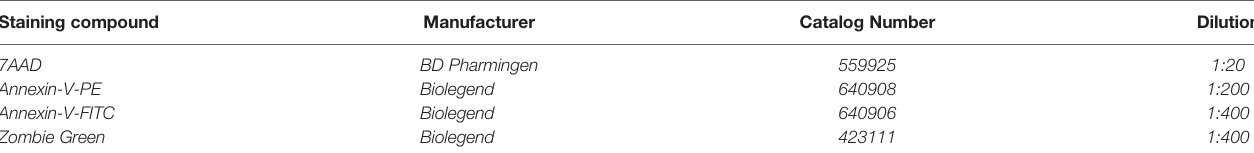
TABLE 2 | Staining compounds used for fl ow